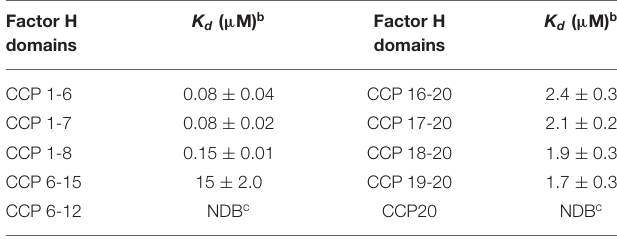
FIGURE 4 | approach saturation. The K d was determined by fitting the data using non-linear regression to a single site ligand binding equation (Bound = (Capacity*[Free])/( K d + [Free])) using GraFit 5 program ( Erithacus ). C3b was dialyzed into HBS-P. (B) Same as (A) , except purified rH 19-20 was attached to the Ni-NTA surface, (C) Same as (A) , except purified rH 6-15 was attached to the Ni-NTA surface. Higher concentrations of C3b were required in (B,C) due to the lower affinity of these proteins for C3b.